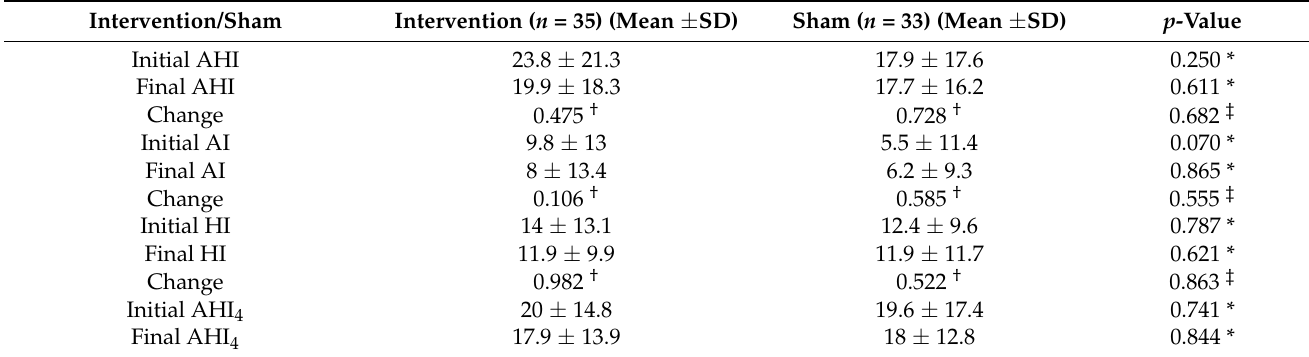
Table 2. Polysomnography results in intervention and Sham groups.